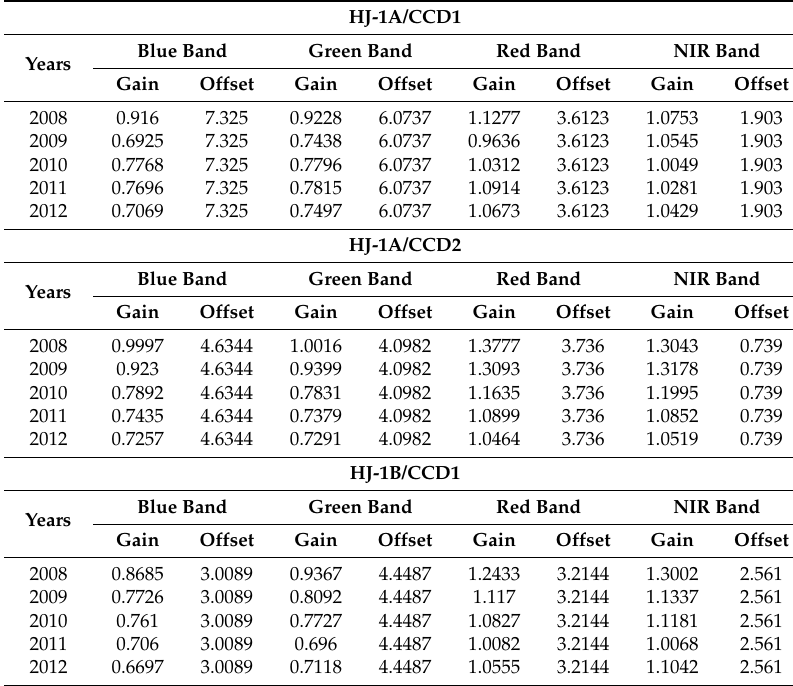
Table 2. The calibration coefficients of CCDs.